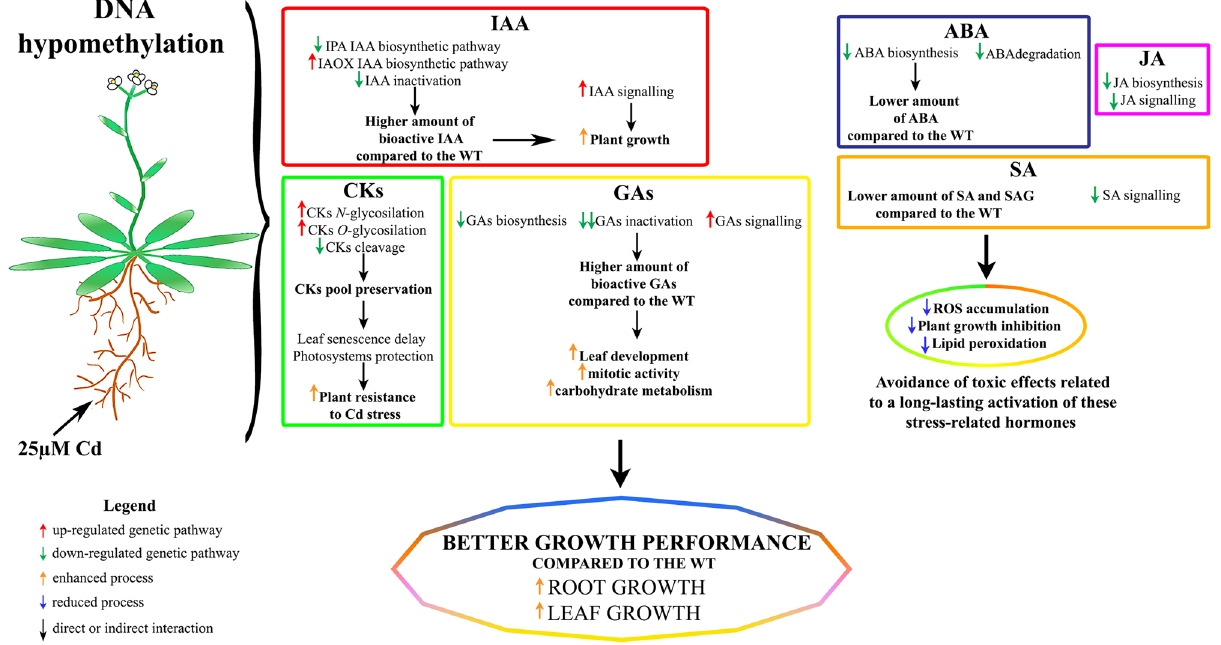
Figure 9. Scheme summarizing the modifications in hormone-related genetic pathways in A. thaliana ddc mutant plants under 25 µM Cd stress. The related effects of these modifications are also